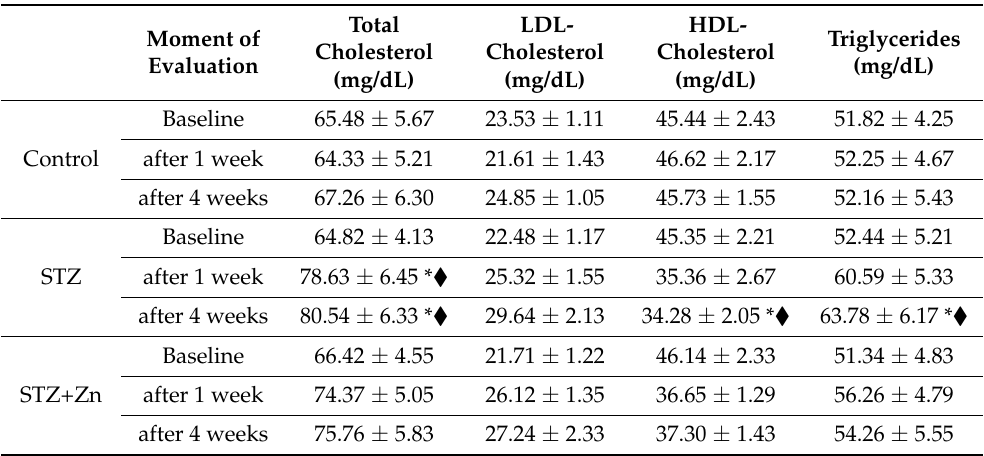
Table 5. The influence of Zn on the serum levels of total cholesterol, LDL-cholesterol, HDL-cholesterol and triglycerides in diabetic rats (LDL-cholesterol—low-density lipoprotein cholesterol, HDL- cholesterol—high-density lipoprotein –cholesterol). The values are presented as mean value ± S.D. for five animals per lot. * p < 0.05 versus control; (cid:7) p < 0.05 versus baseline.